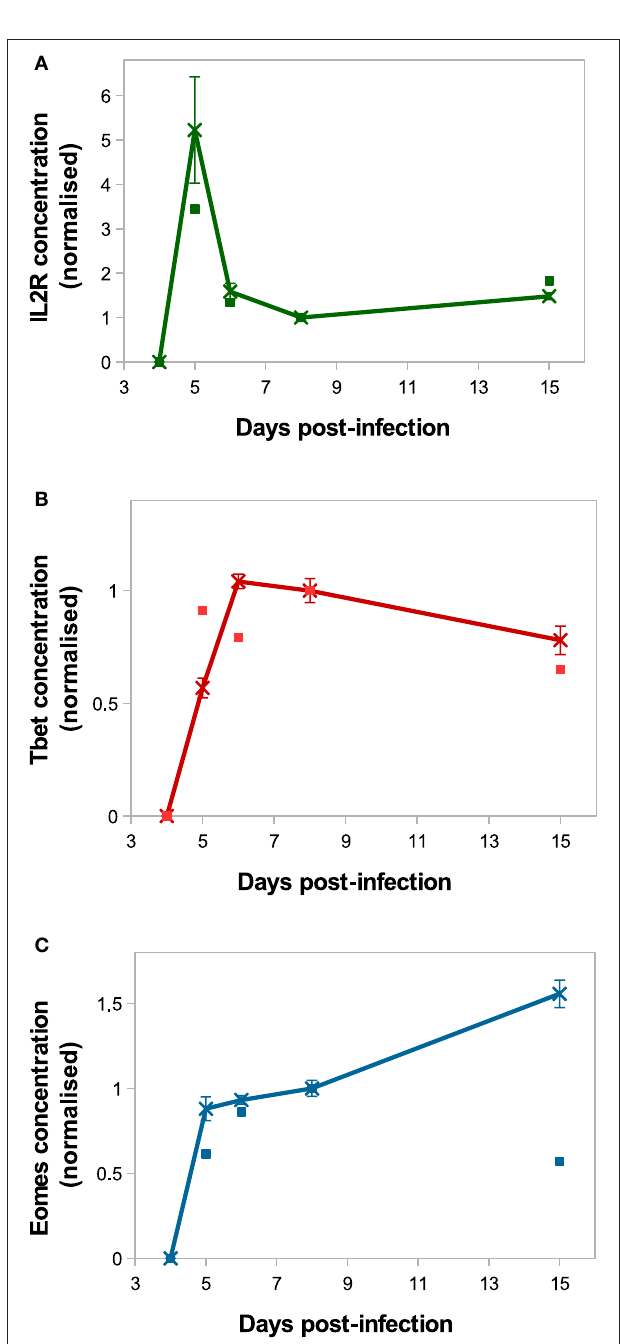
FIGURE 4 | Molecular dynamics. Mean concentration of (A) both activated and inactivated IL2 receptors, (B) Tbet and (C) Eomes among the CD8 T-cell population normalised by the concentration value D8 p.i. Lines with crosses: in silico (mean ± standard deviation over 10 simulations); squares: in vivo mRNA data from